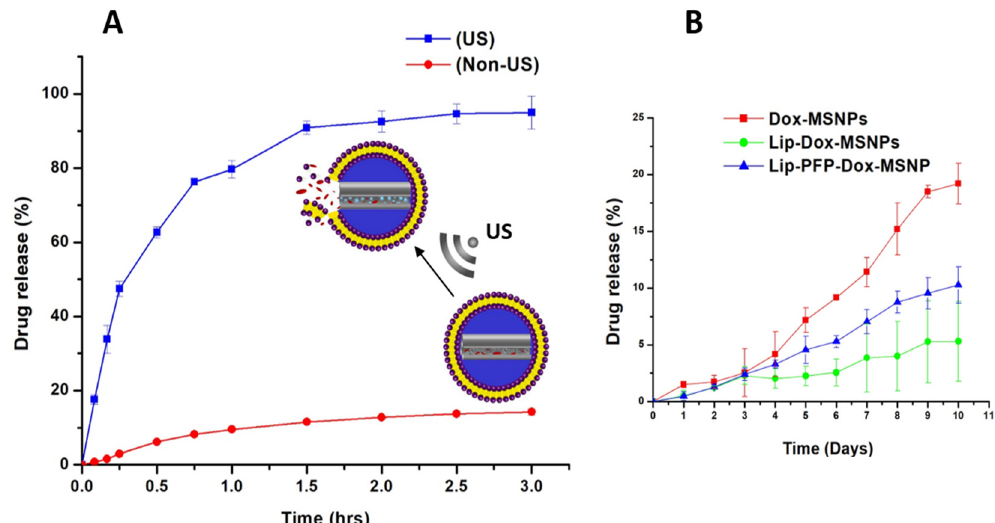
Figure 5. Representative image of ( A ) drug release profile of Doxorubicin from Lip-PFP-Dox-MSNPs versus Lip Dox-MSNPs with and without US-irradiation. ( B ) Drug release profile of Dox-MSNPs, Lip-Dox-MSNPs, and Lip-PFP-Dox-MSNPs under inert conditions (Non-US) with PBS buffer at 4 °C.